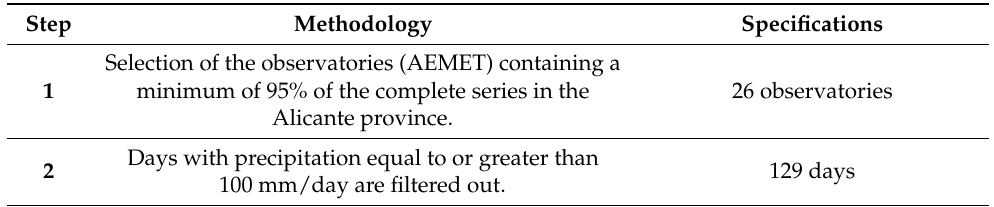
Table 1. Steps of the general